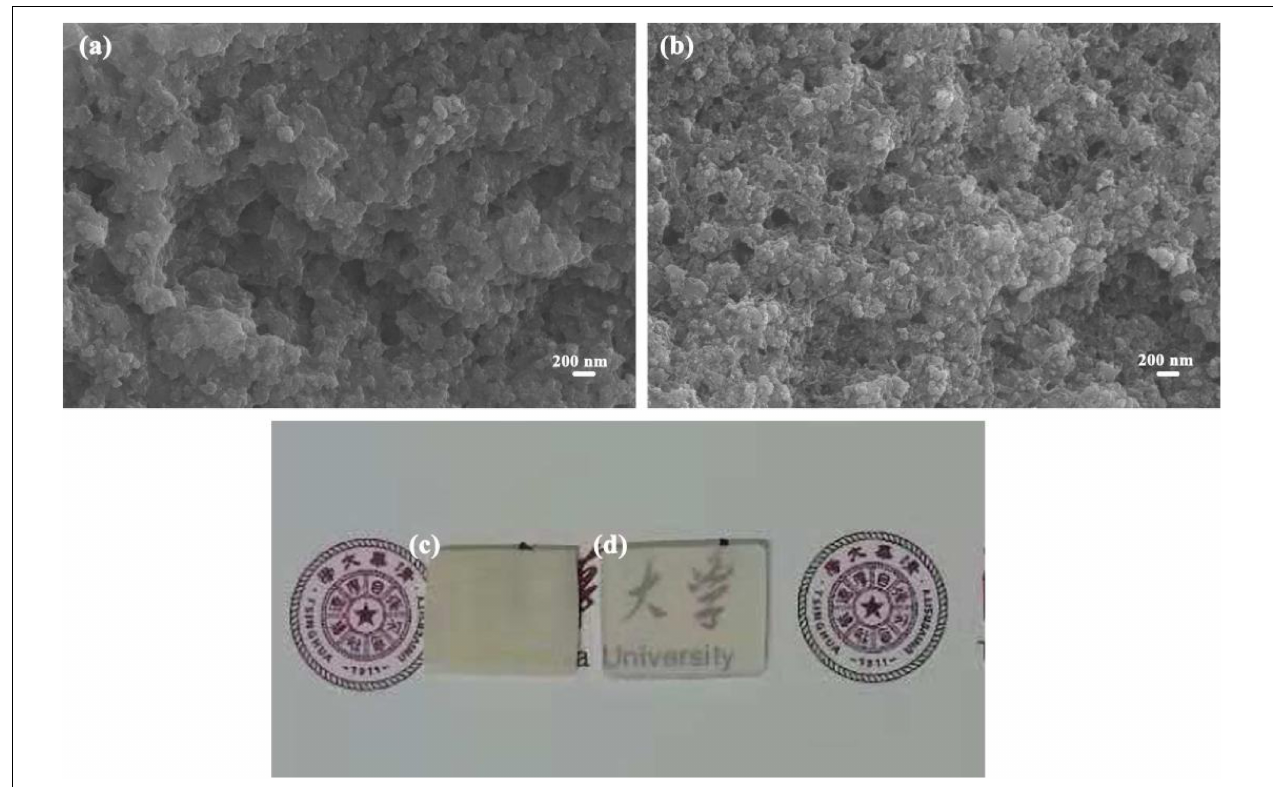
FIGURE 3 | Micro-structures and sample photographs of two PICNs. (a,c) PICN BTC, (b,d) PICN UTC.